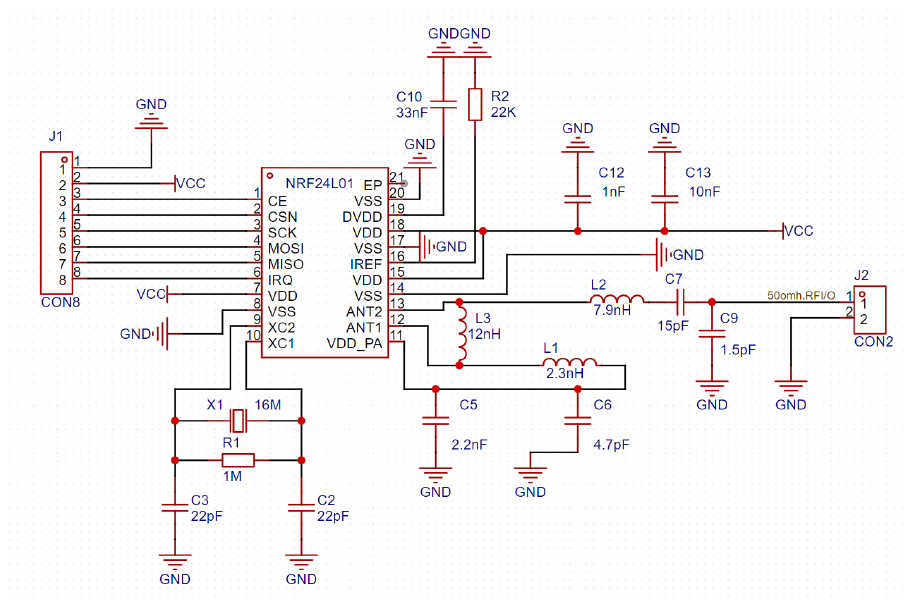
Figure 8. Circuit diagram of NRF24L01.